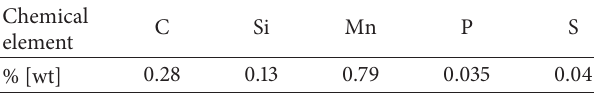
Table 1: Chemical composition of ASTM A516 grade 70. Chemical C Si Mn P S element % [wt] 0.28 0.13 0.79 0.035